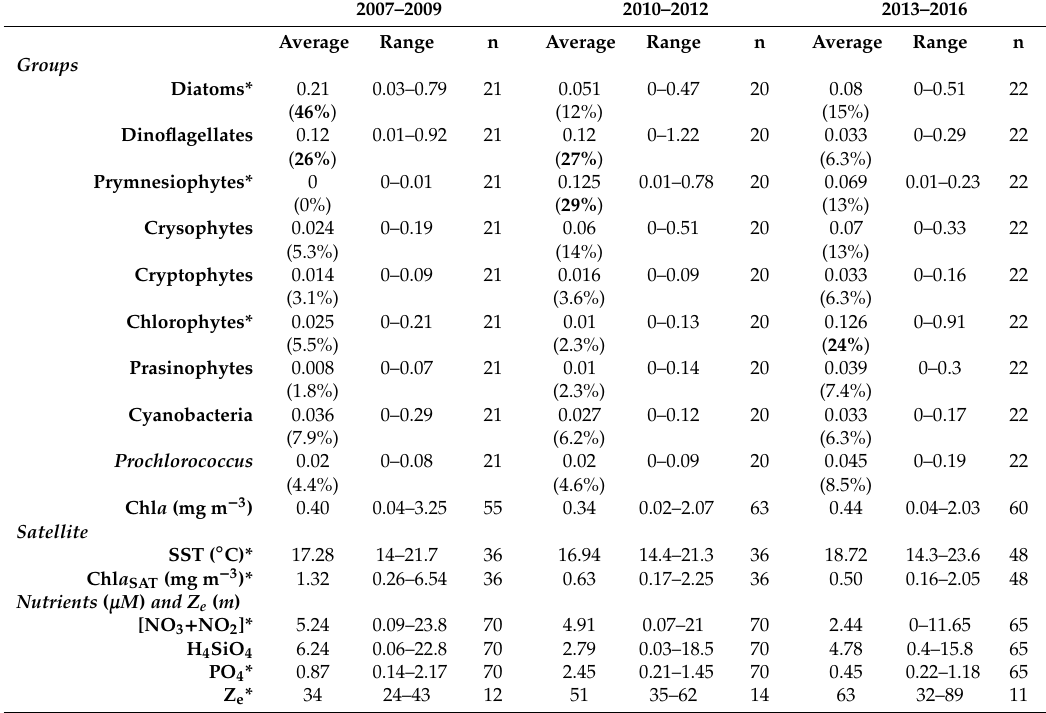
Table 5. Average, range (minimum and maximum) and number of data (n) for in situ and satellite data measured by period. The concentration of each phytoplankton group is expressed in mg / m 3 ; numbers in parentheses indicate the percent contribution of each group to the entire community; numbers for groups that contributed above 20% are marked in bold. Variables indicated with an asterisk (*) showed significant statistical di ff erences between time